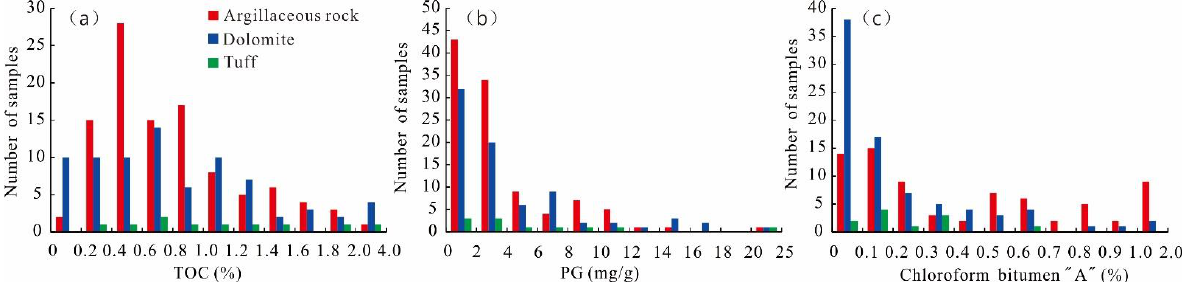
Figure 2. Distribution histograms of organic matter abundance in the Fengcheng Formation in the Mahu Sag. ( a ) Histogram of TOC distribution. ( b ) Histogram of PG distribution. ( c ) Histogram of chloroform bitumen “A” distribution.